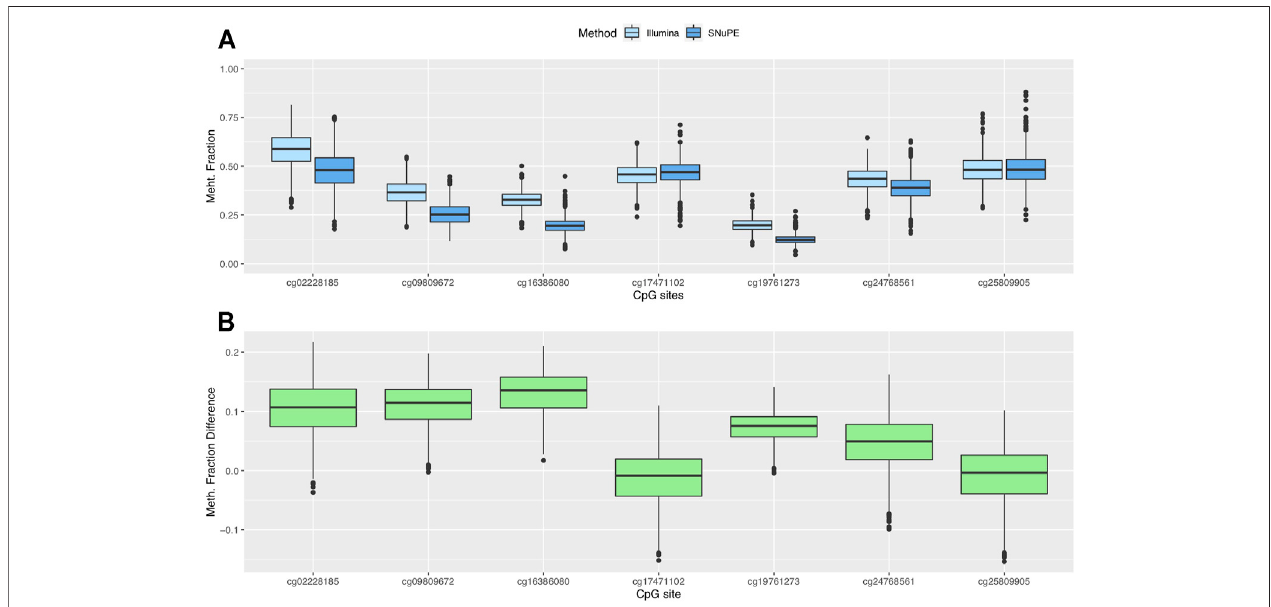
FIGURE 1 | Boxplots of methylation fraction measured by the SNuPE and EPIC array method (A) and difference between both methods (B) .